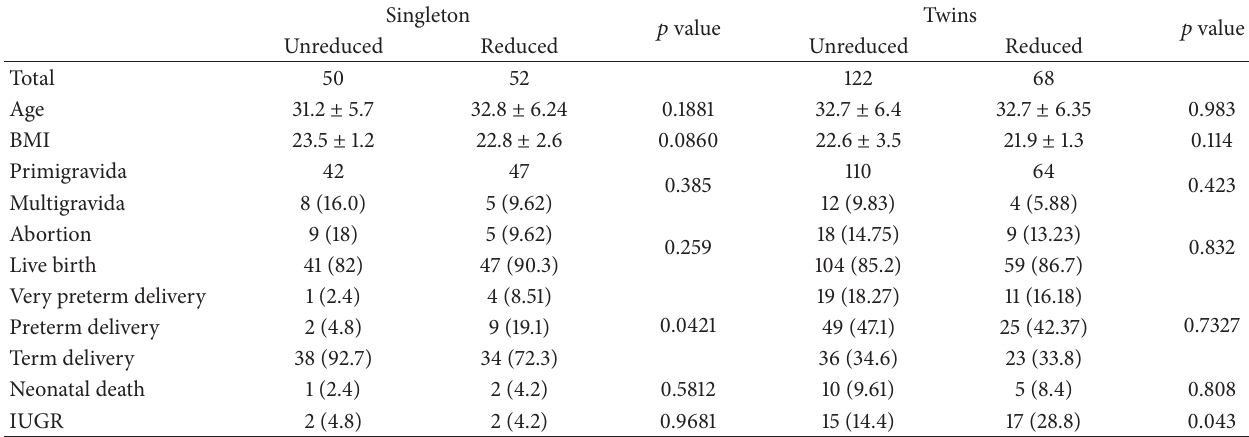
Table 1: Perinatal outcome in singleton and twin gestation.